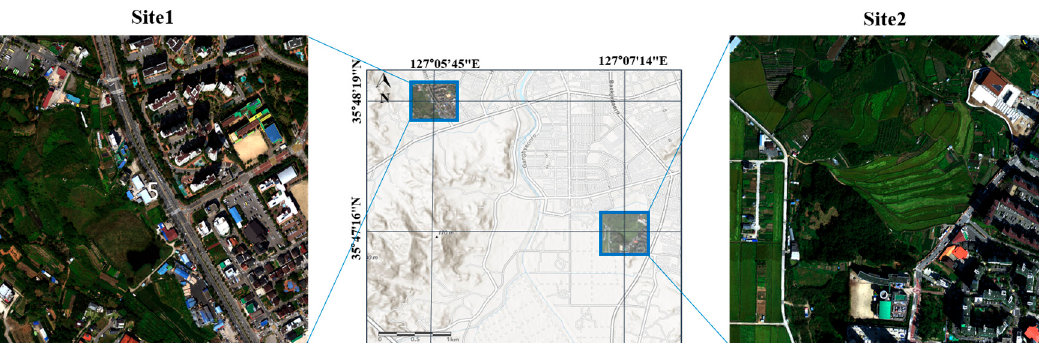
Figure 5. Locations of the two study sites in South Korea, along with their UAV hyperspectral images. The background map was obtained from ArcGIS (a geographic information system (GIS) for working with maps and geographic information maintained by Esri) world map [32]. The hyperspectral UAV images were obtained on September 19, 2019.